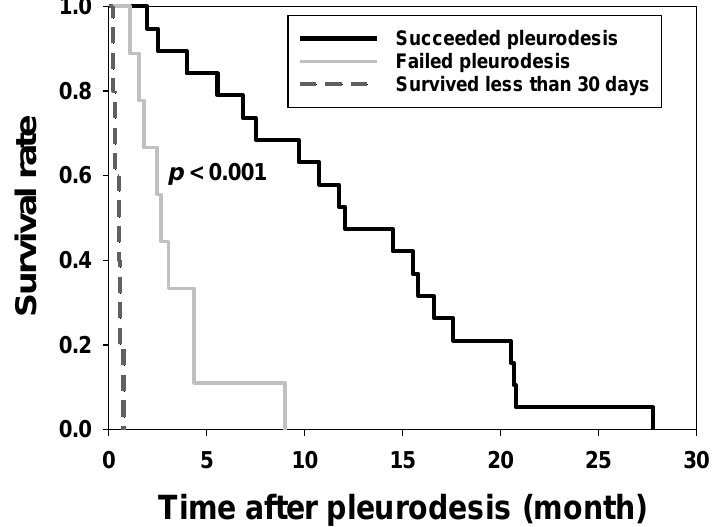
Figure 1. Survival after pleurodesis. The survival rates of patients who underwent successful pleurodesis (black line), patients for whom pleurodesis failed (grey line), and patients who survived less than 30 days (dotted line) were plotted against the time after pleurodesis.